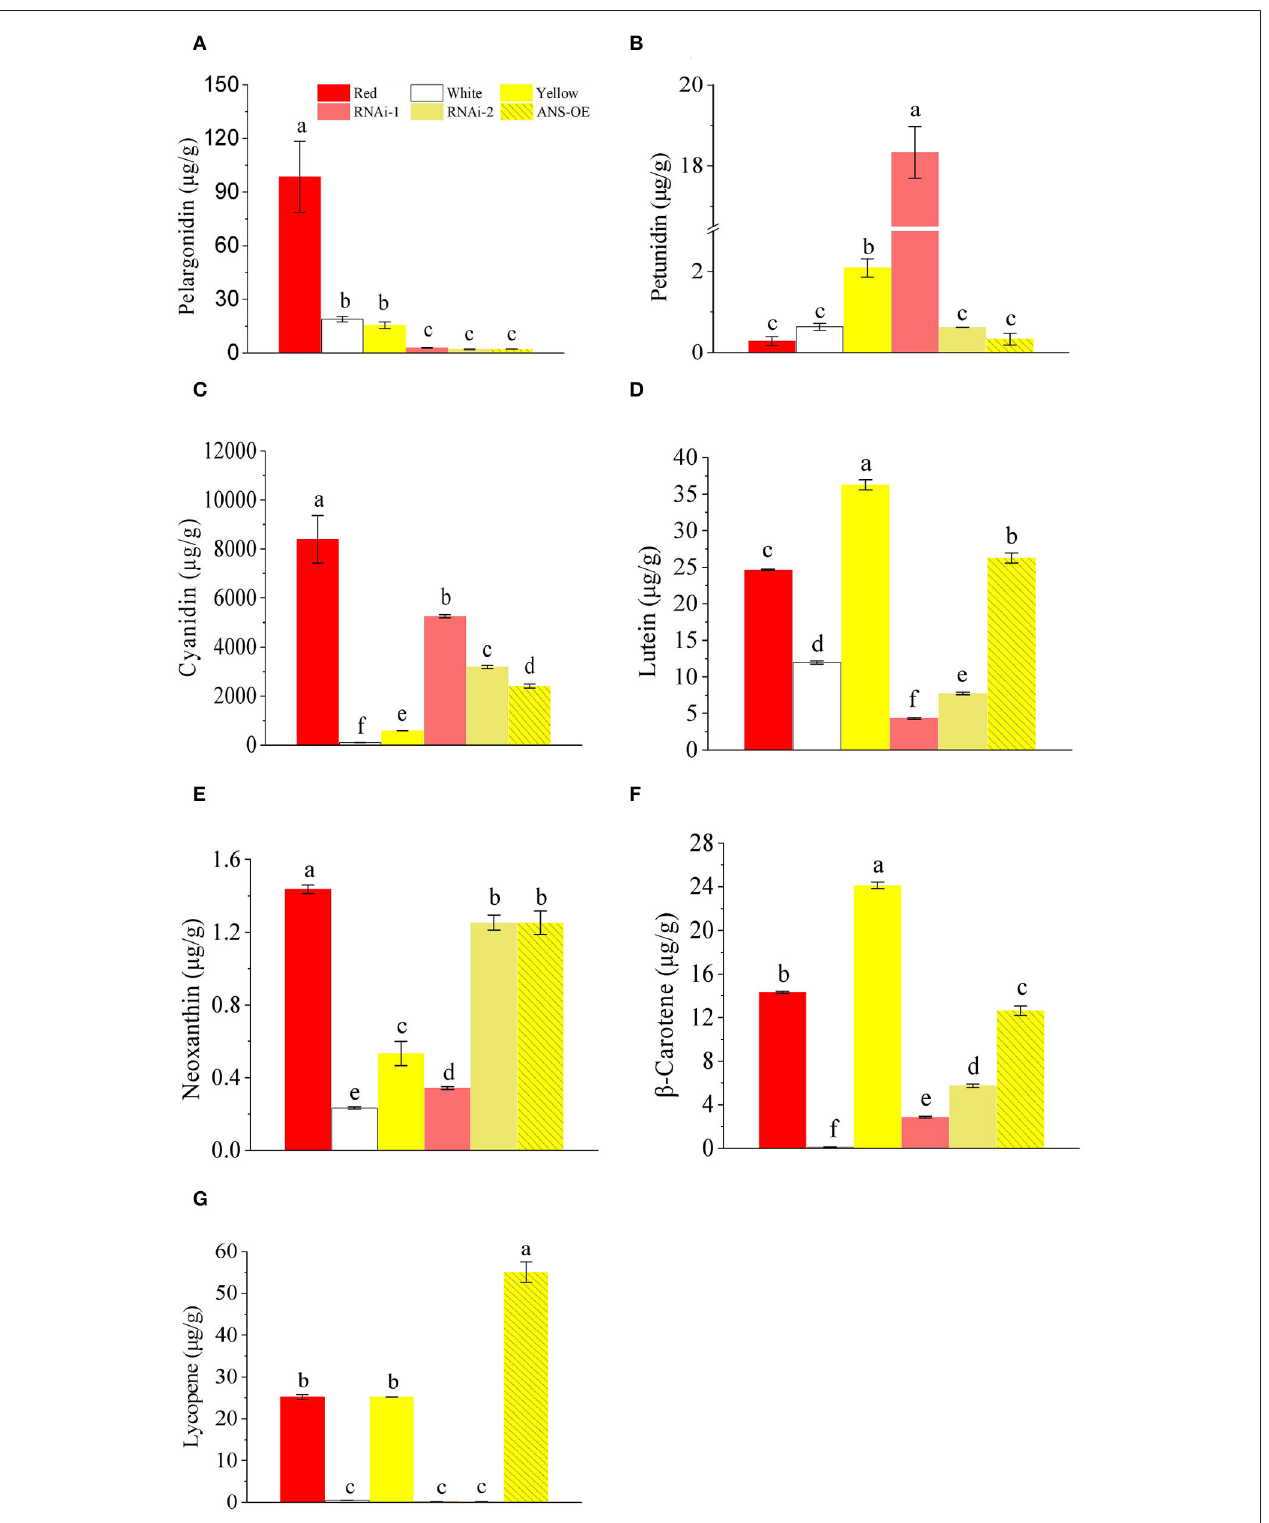
FIGURE 7 | Comparison of anthocyanins and carotenoids contents in petals of red (V1), white (V2), yellow (V3), RNAi lines, and overexpression lines. (A) pelargonidin; (B) petunidin; (C) cyanidin; (D) lutein; (E) neoxanthin; (F) β -carotene; (G) lycopene. Letters above the columns represent a significant difference, p ≤ 0.05. Error bars represent SD